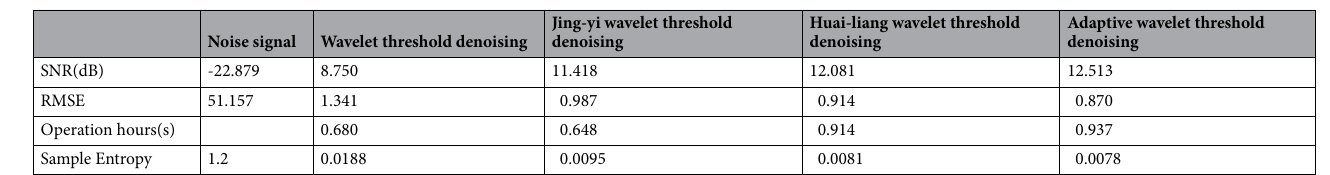
Table 6. Quantitative evaluation of the denoising effect of microseismic analog signals based on different methods.